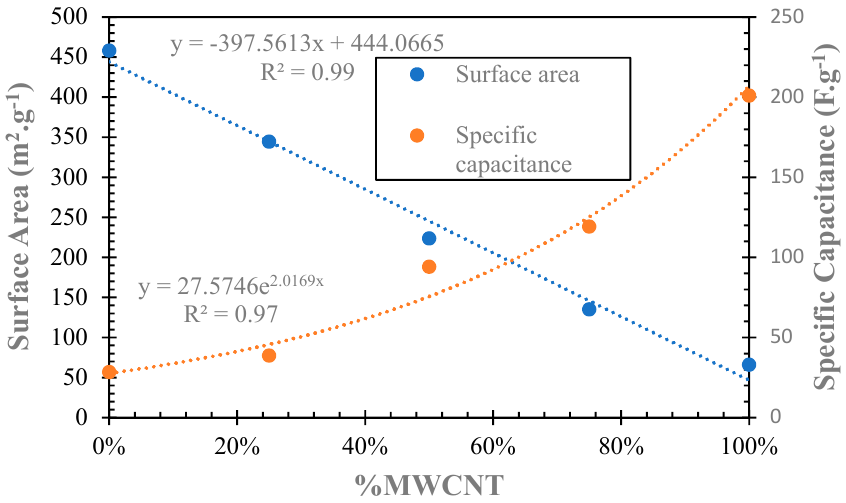
Figure 7. The combination plot showed the fluctuation of both specific capacitance and specific surface area with different ratios of MWCNT and FHY in the composite material.